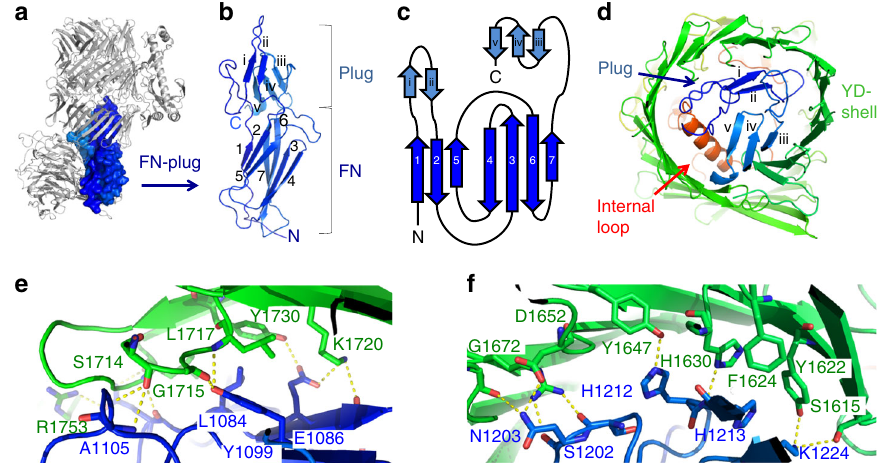
Fig. 2 The FN-plug domain. a The Ten2 FN-plug domain is shown in surface representation and coloured as in Fig. 1b. The rest of the protein is shown as grey ribbons, oriented as in Fig. 1b. b The FN-plug domain (residues 1045 – 1237 in Ten2) is shown as ribbons. The FN and plug sub-domains are indicated. c The secondary structure of the FN-plug domain is shown as a cartoon where each arrow represents a β -strand. All β -strands are numbered as in b . d View of the FN-plug domain (blue) showing its position within the YD shell (green). The strands of the FN-plug domain are numbered as in b . e , f Zoomed views depicting selected interfacing residues of the FN-plug and YD-shell domains. A plot of all interfacing residues is provided in Supplementary Fig.